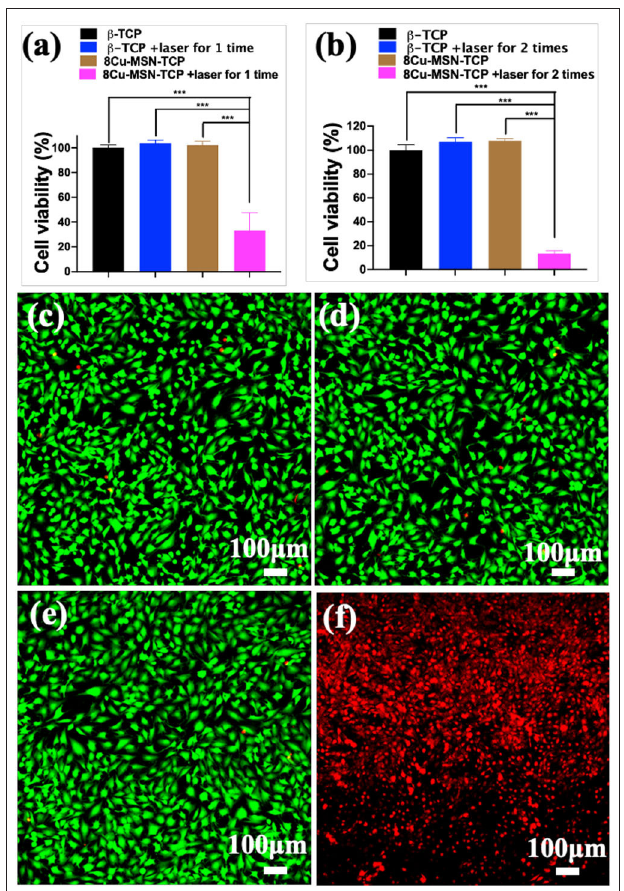
FIGURE 5 | The viability of MG-63 tumor cells, treated with 8Cu-MSN-TCP scaffolds after being irradiated once (a) and twice (b) ( n = 3). Confocal laser scanning microscope images of MG 63 tumor cells treated with β -TCP without irradiation (c) , β -TCP scaffold with irradiation (d) , 8Cu-MSN-TCP without irradiation (e) , and 8Cu-MSN-TCP with irradiation (f) . MG 63 tumor cells were stained with calcein AM (green fluorescence, live cells) and ethidium homodimer-1 (red fluorescence, dead cells). Hyperthermia induced by 8Cu-MSs-TCP scaffolds had sufficient killing effect on tumor